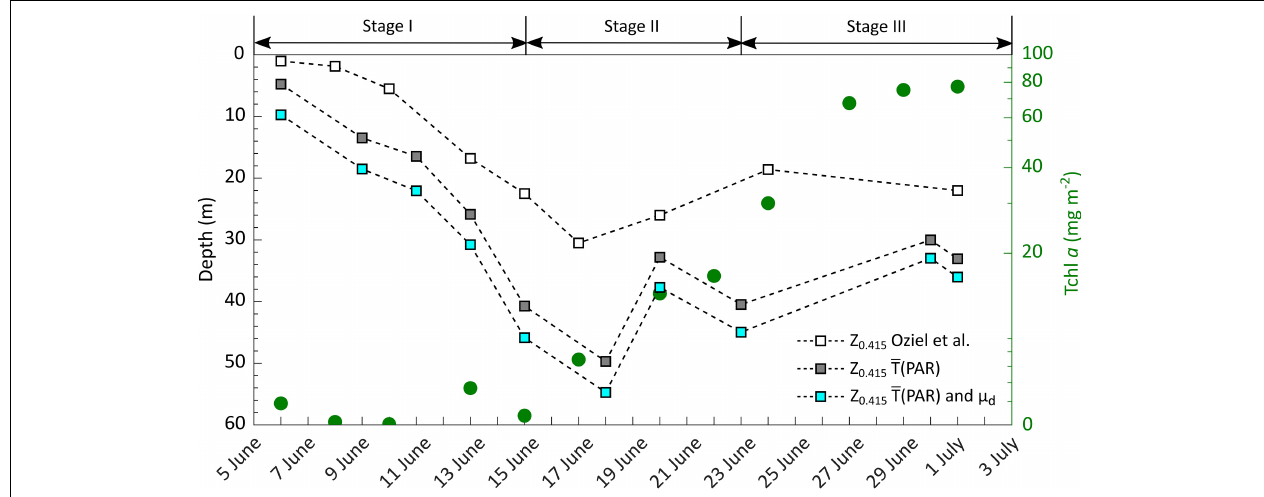
FIGURE 8 | Change in total chlorophyll a (Tchl a ) concentration (green circles) integrated over 100-m water column (Massicotte et al., 2020), and in isolume depth ( z 0 . 415 ), extracted from Oziel et al. (2019, white squares), as well as calculated from mean PAR transmittance ( ¯ T ( PAR ) , gray squares) and calculated from ¯ T ( PAR ) and scalar irradiance using an inverse average cosine ( µ d ) of 1.4 (blue squares) for each melt stage (I – III) at the ice camp